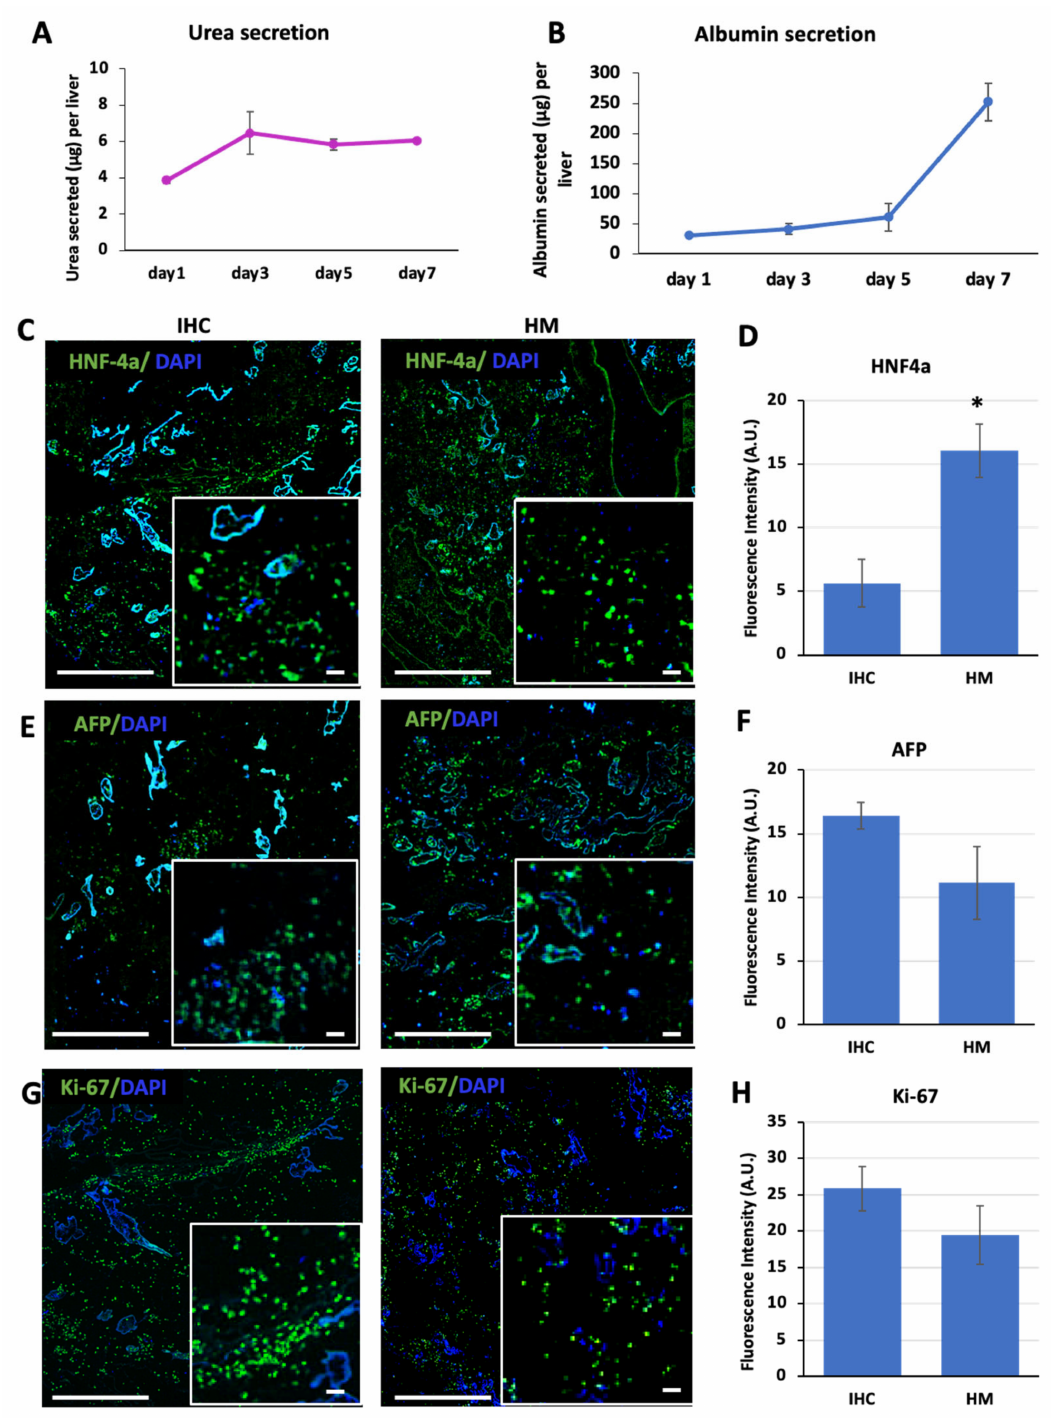
Figure 5. The functional characterization of recellularized rat livers. The amounts of ( A ) urea and ( B ) albumin secreted by the recellularized livers determined on days 1, 3, 5, and 7 were determined for the HM stage. Images of the immunohistochemistry analysis for ( C ) HNF4a, ( E ) AFP, and ( G ) Ki-67 in recellularized rat livers in the IHC and HM stages. Fluorescence intensity quantification of the immunohistochemistry images showing changes in the expression levels of ( D ) HNF4a, ( F ) AFP, and ( H ) Ki-67 in the IHC and HM stages. Three scaffolds at the IHC stage and three scaffolds in the IHC+ stages were analyzed for quantification. (* indicates statistically significant differences ( p < 0.05); scale bars = 200 µ m; scale bars for insets = 50 µ